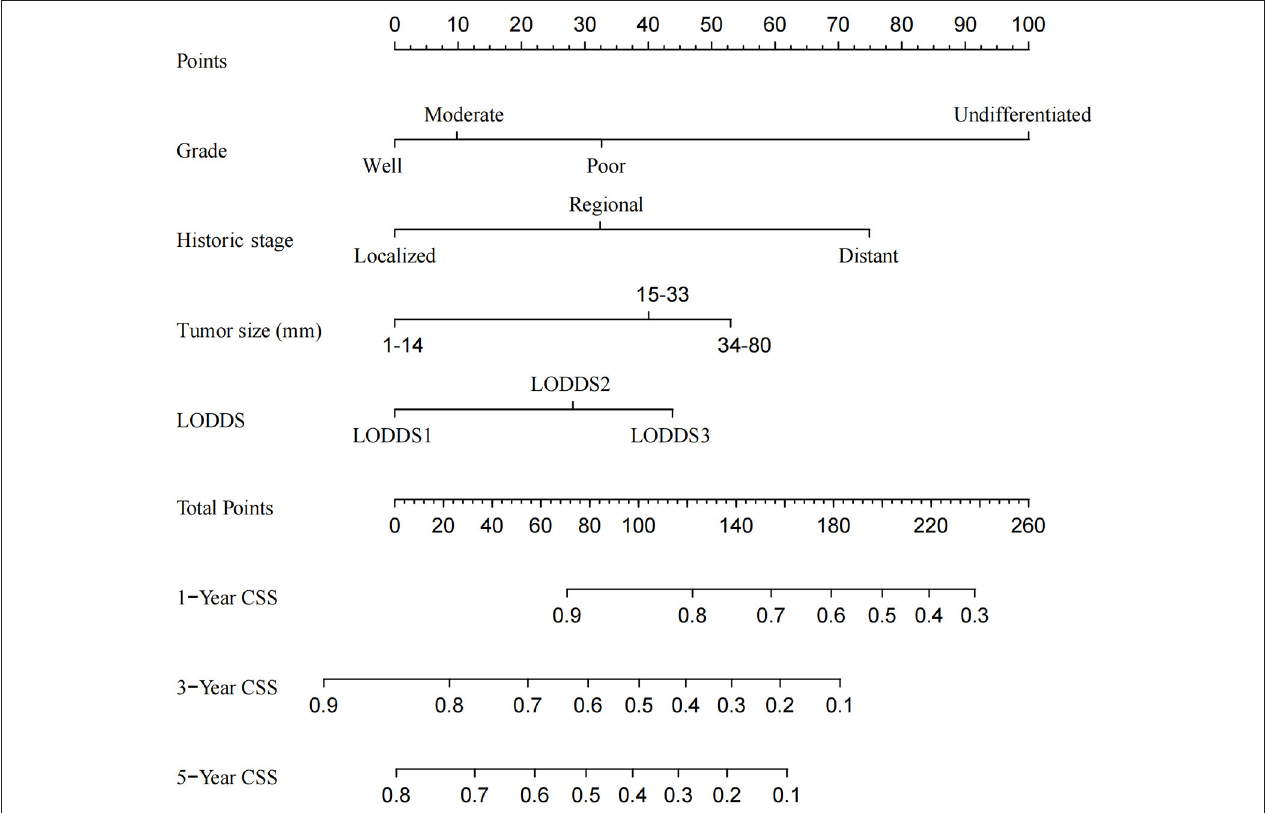
FIGURE 2 | Nomogram for predicting the 1-, 3-, and 5-year cancer-specific survival in patients with distal